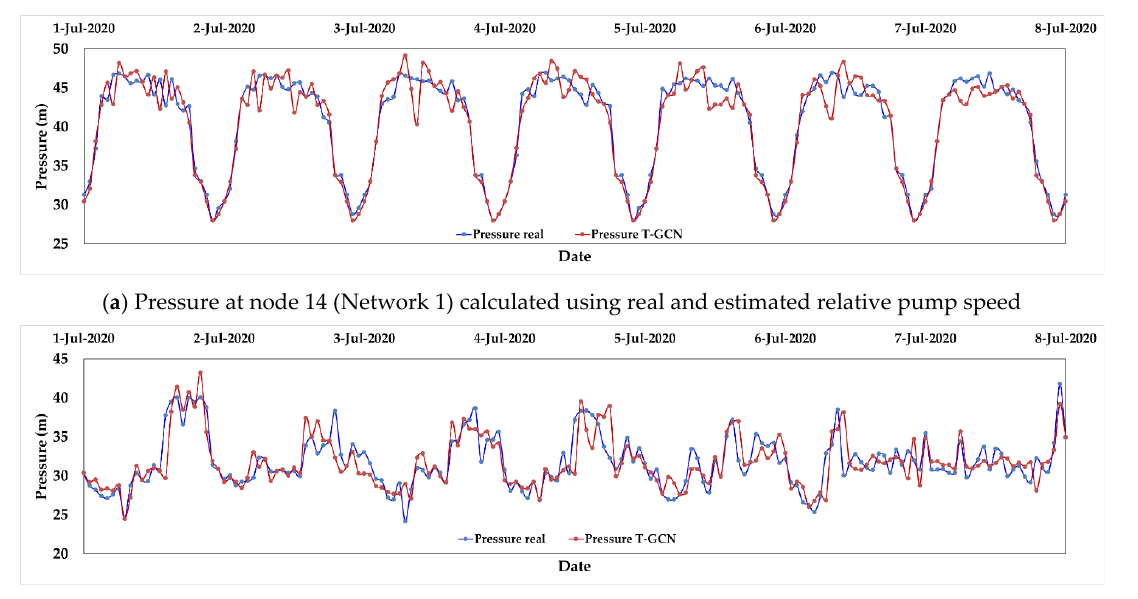
Table 3. Evaluation parameters of the T-GCN model in pressure and flow rate. Network 1